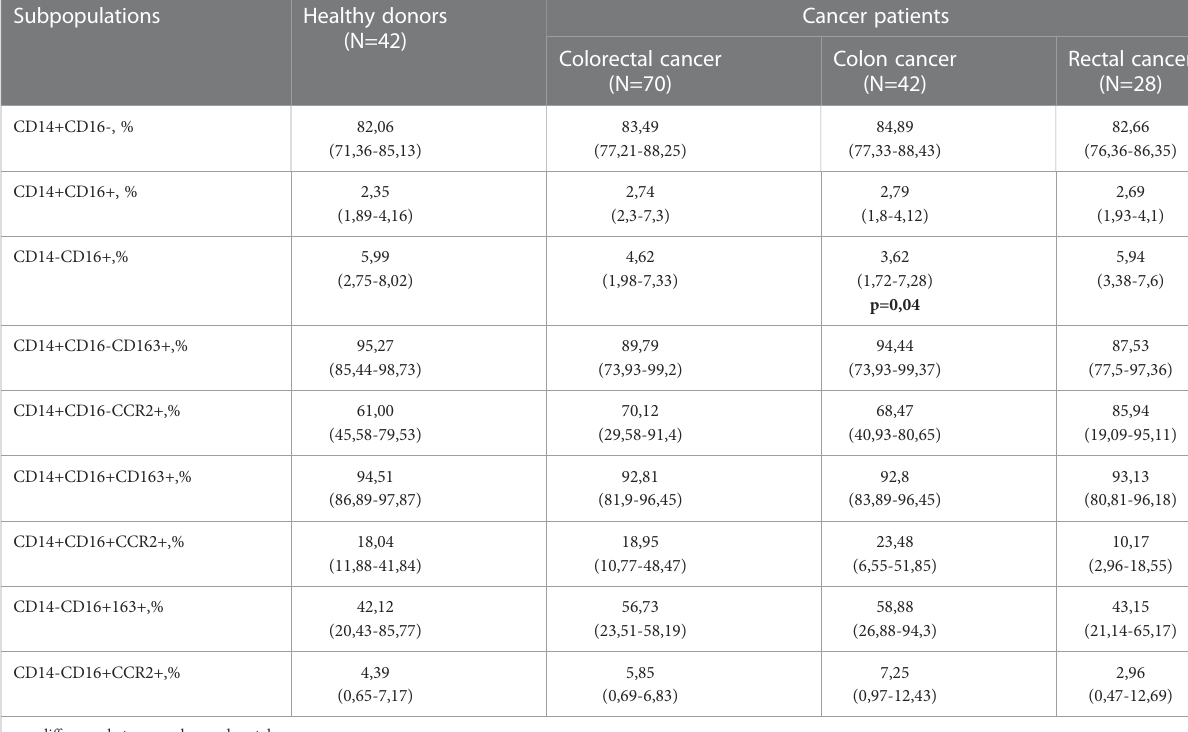
TABLE 1 Monocyte subpopulations` content in healthy individuals and CRC